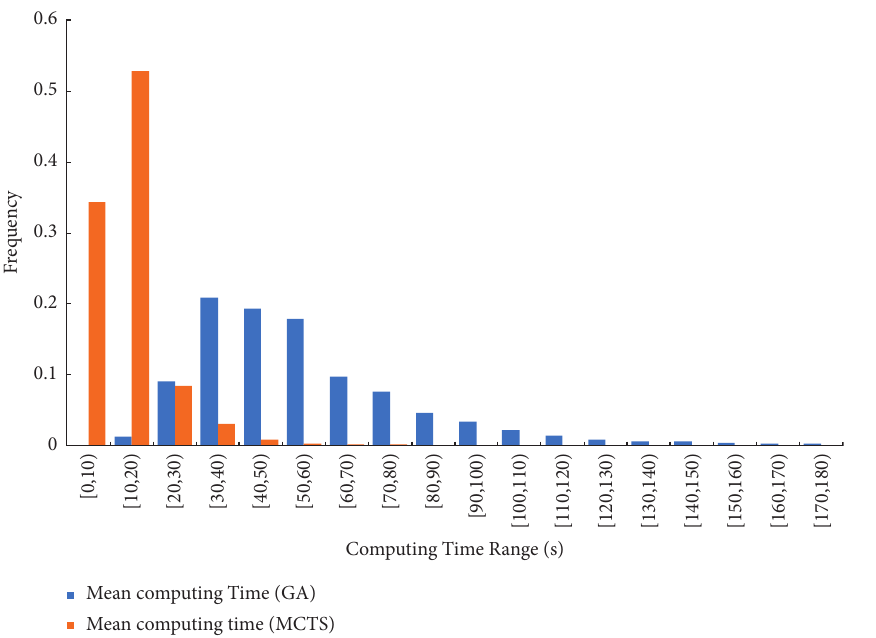
Figure 12: The histogram of computing time. The blue bar is the computing time of the GA, and the yellow bar is the computing time of the